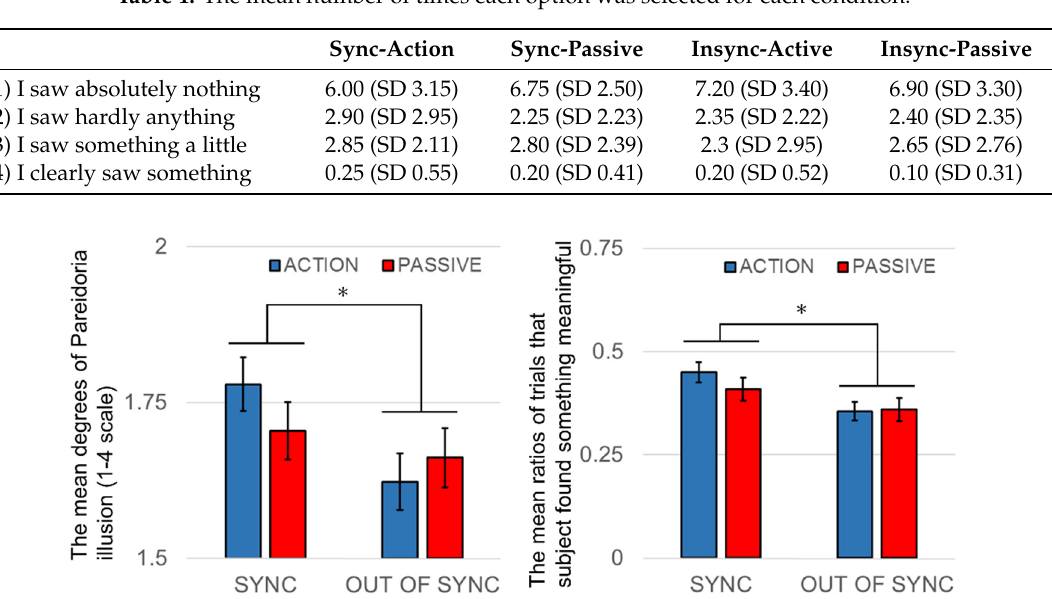
Table 1. The mean number of times each option was selected for each condition.